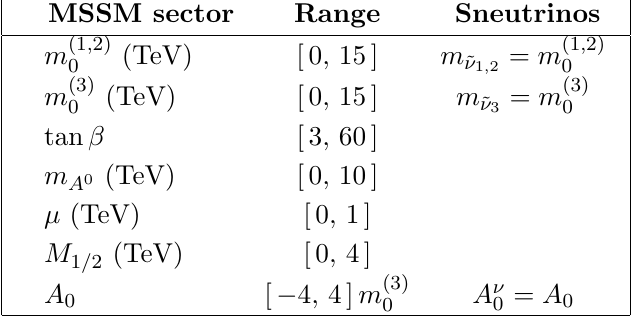
Table 3 . Parameter space of the numerical